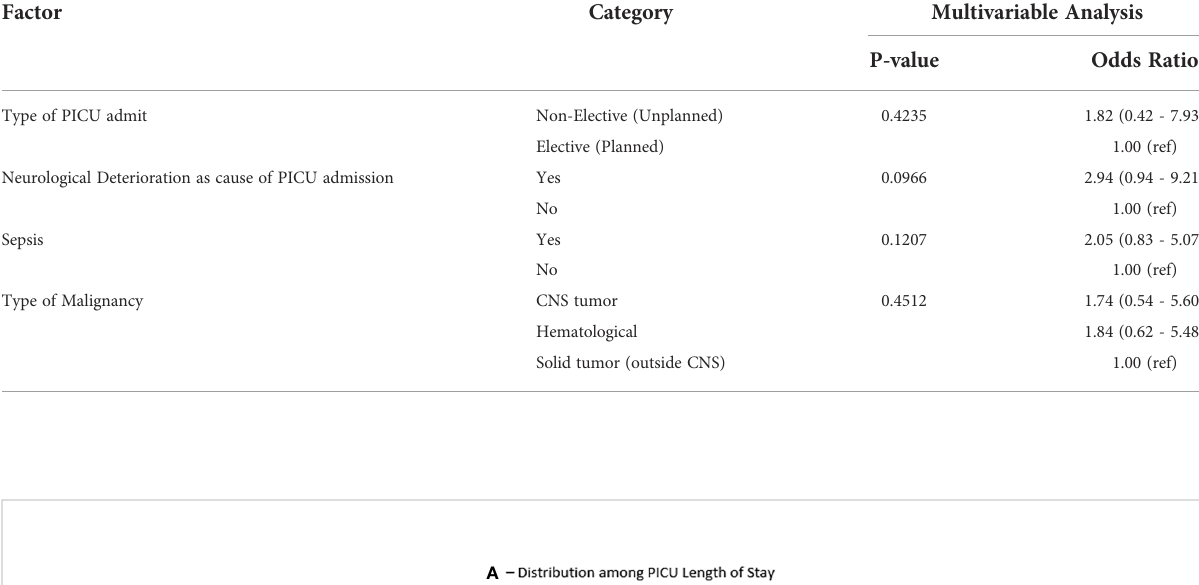
TABLE 4 Multivariate analysis of Risk Factors for Mortality (GEE Model) among all admissions (NOT including PIM2).